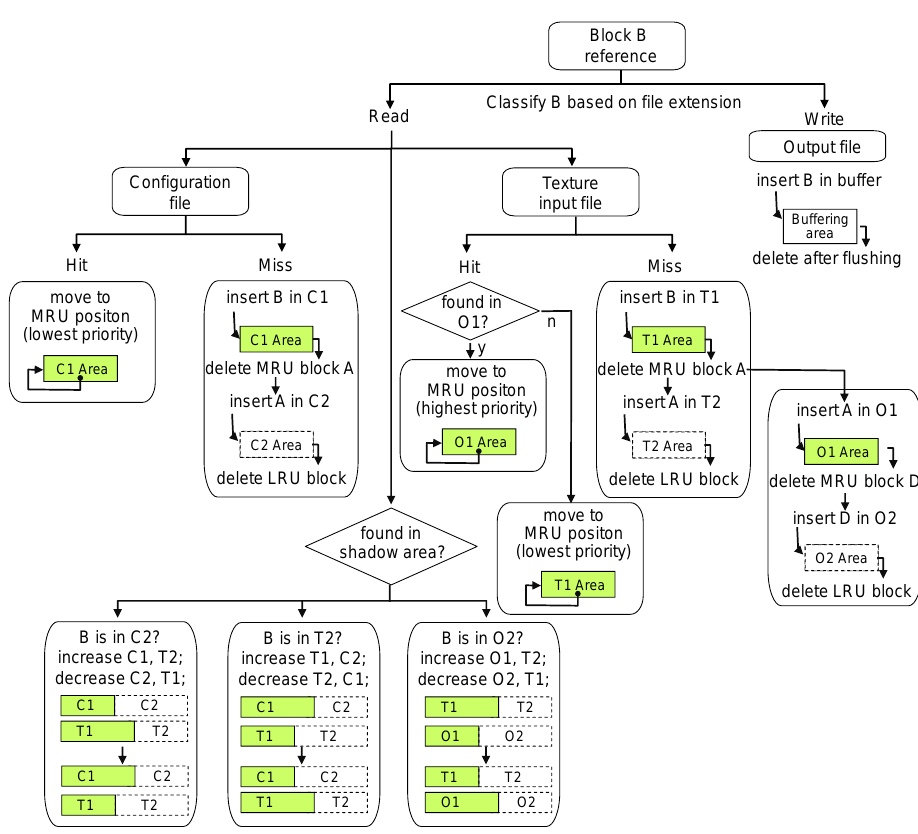
Figure 6. A conceptual flow of the proposed algorithm.